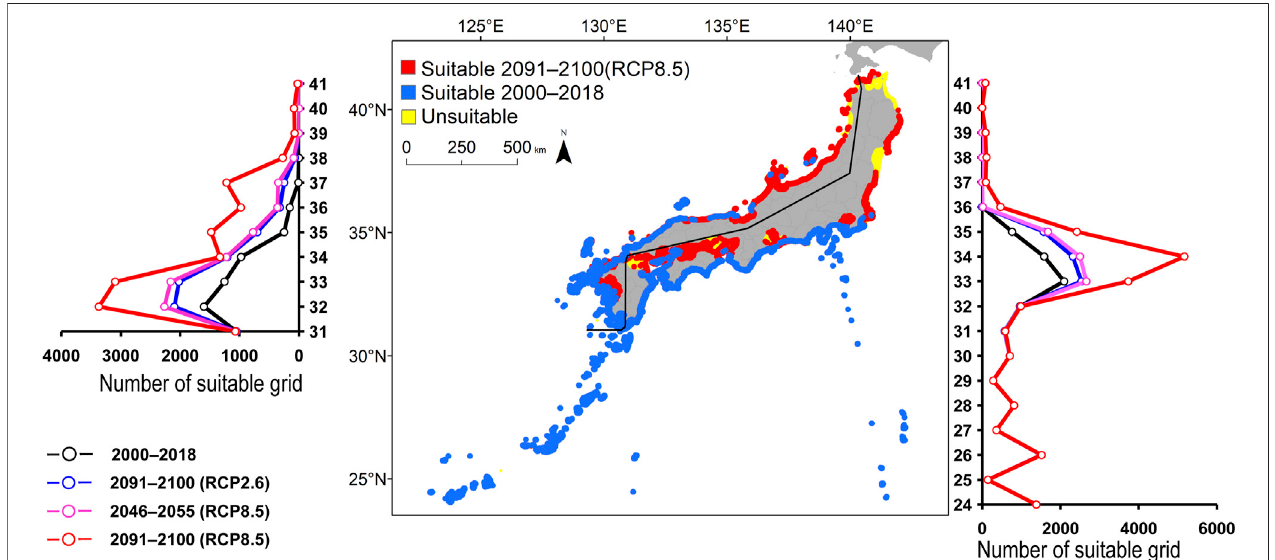
FIGURE 5 | Estimated distribution of Siganus fuscescens . See Figure 2 for the explanation.